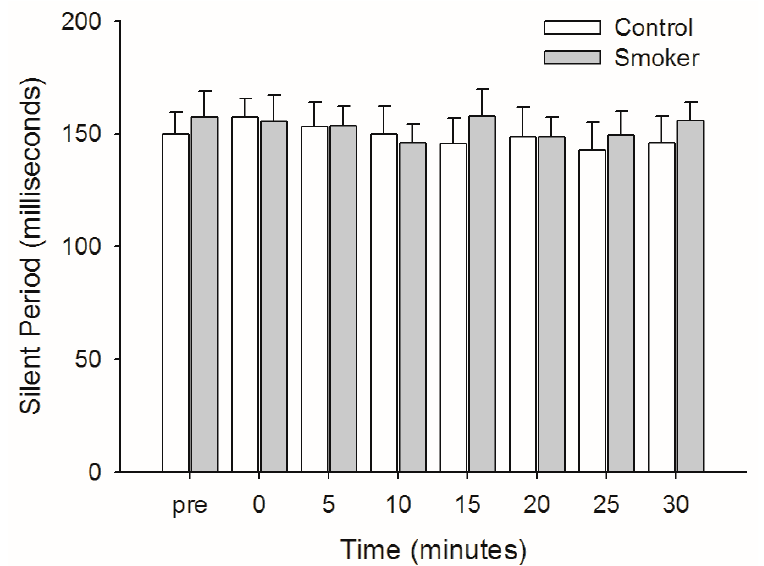
Figure 4. Mean silent period in milliseconds for control and smoker groups. Error bars indicate standard error of the mean.